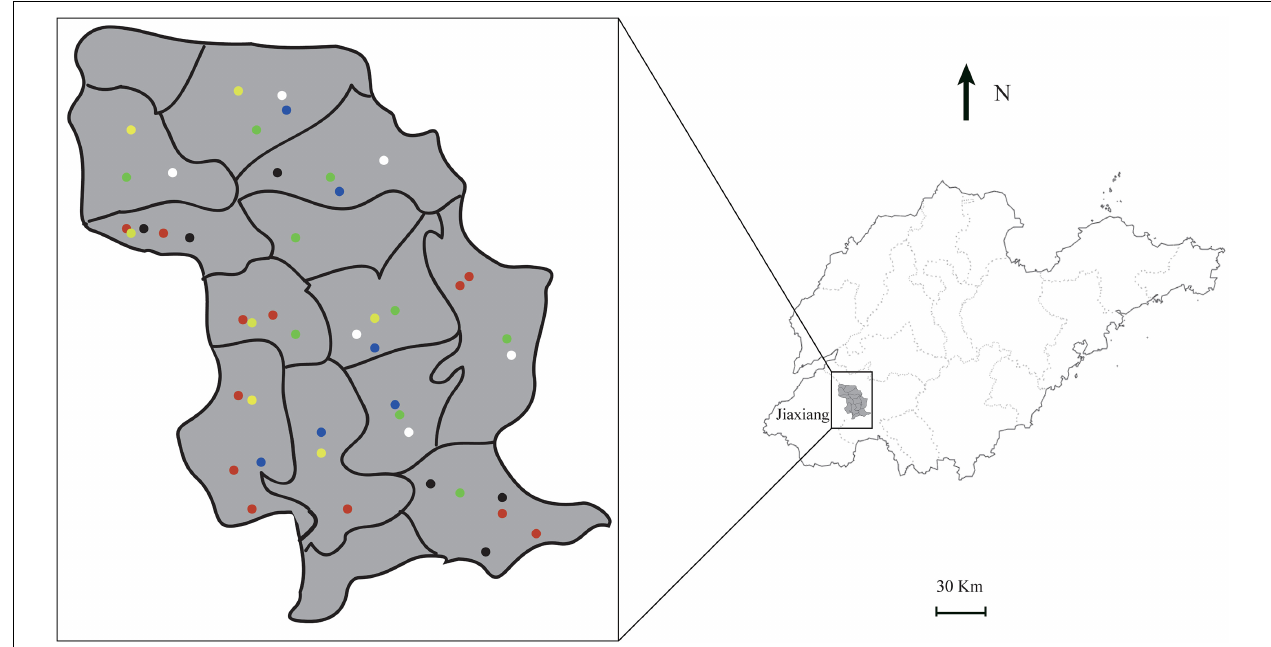
FIGURE 1 | Locations and habitats type of sampling sites in Jiaxiang County. Six black dots represent small puddles, 12 red dots representing small water containers, seven yellow dots representing paddy fields, nine green dots representing large water containers, six white dots representing irrigation channels, and six blue dots representing drainage ditches. The location of each dot displayed a sampling